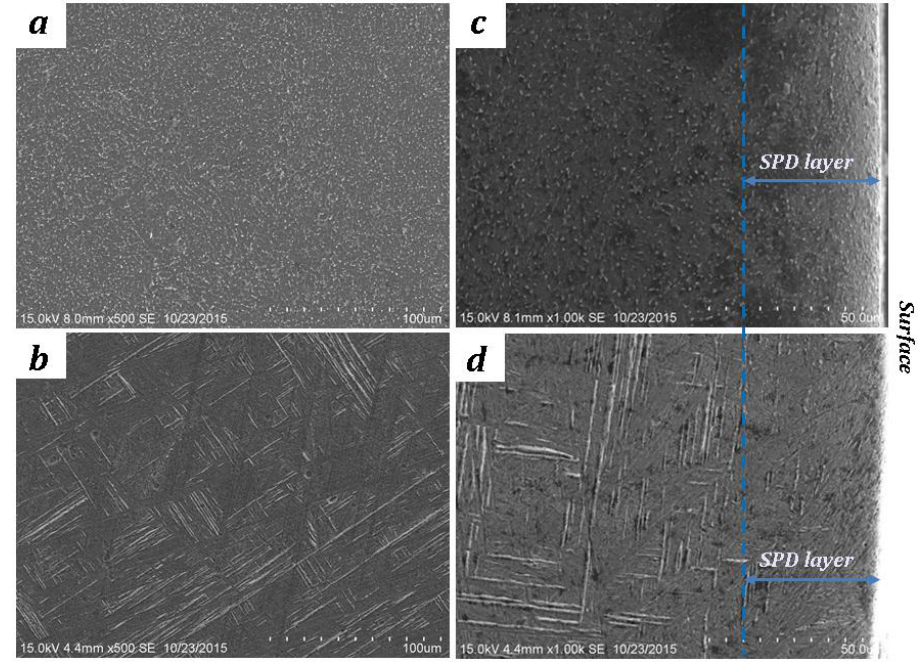
Figure 2. Microstructure and dissimilation surface layer of TC4: ( a ) SRA; ( b ) SSA; ( c ) SRA-UNSM; ( d ) SSA-UNSM.